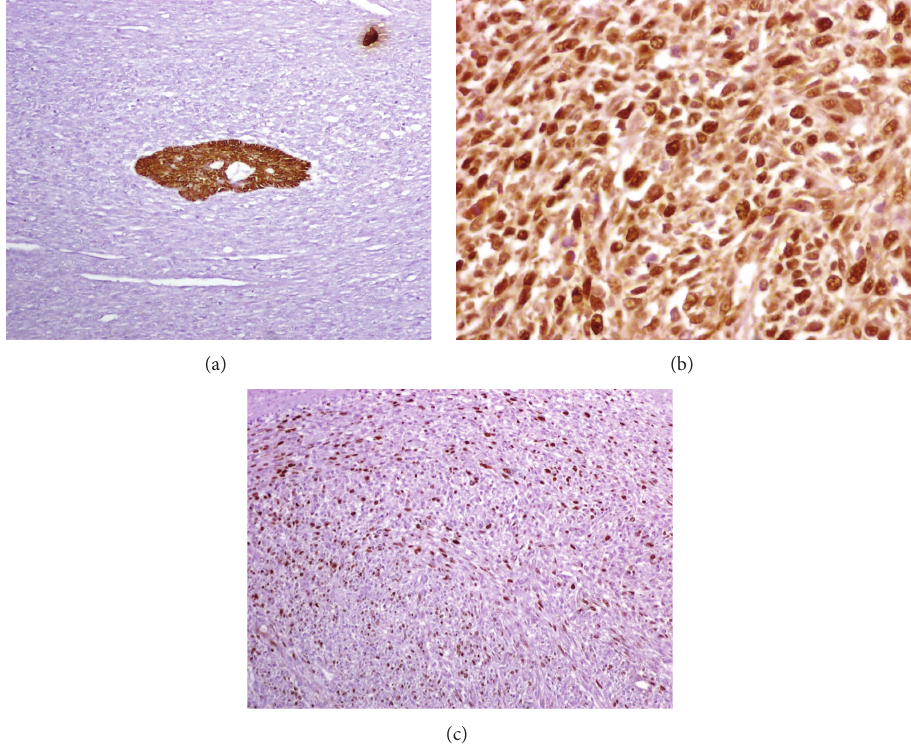
Figure 3: (a) Reactivity to Cytokeratin AE1/AE3 in the epithelial component, lack of reactivity in the mesenchymal component. Immunohistochemical stain with anti-Cytokeratin AE1/AE3 antibody, × 50. (b) Reactivity to Vimentin in the mesenchymal component. Immunohistochemical stain with anti-Vimentin antibody, × 400. (c) Reactivity to Ki67 in the mesenchymal component with a labeling index of 30%. Immunohistochemical stain with anti-Ki67 antibody, × 50.